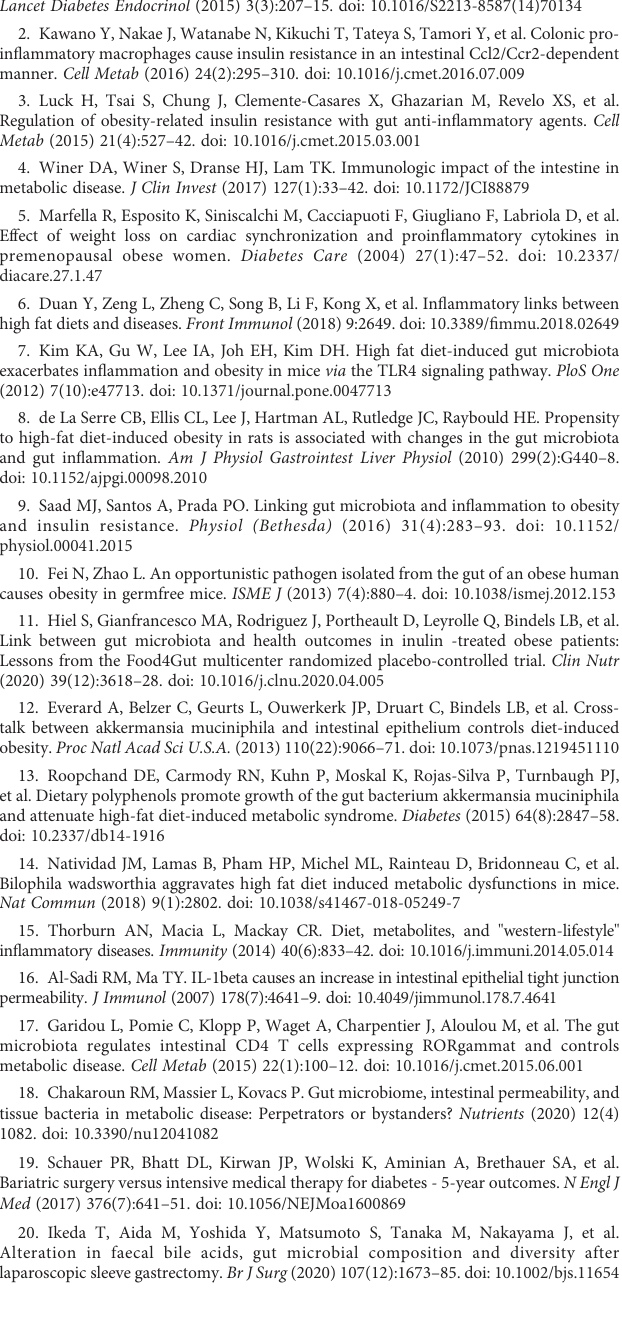
with post hoc Tukey ’ s test for multiple comparisons (Panel A , B , C , and D ) was used forsigni fi cance assessments. **P < 0.01,*P < 0.05SHAM vsSG; ## P < 0.01, SHAM-ABX vs SG-ABX. SHAM = sham surgery, SG = sleeve gastrectomy, ABX = antibiotics. SUPPLEMENTARY FIGURE 5 SGsigni fi cantlymodulates the colonic transcriptome. (A-B) Enrichmentanalysis of Kyoto Encyclopedia of Genes and Genomes (KEGG) based on differentially expressed genes (DEGs) between SHAM vs. SG (A) and SHAM-ABX vs. SG-ABX (B) . n =